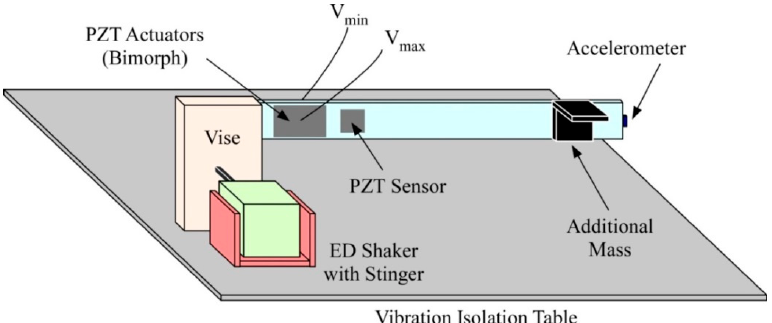
Figure 9. Schematic of experimental setup.